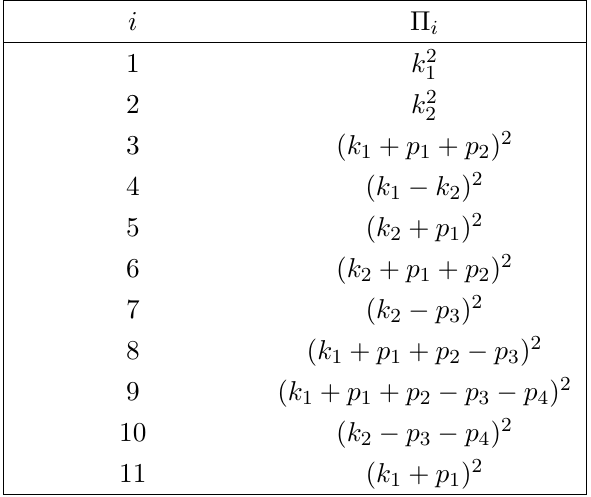
Table 1 . The propagators { Π i } defining the 2-loop 5-point planar integrals I b .